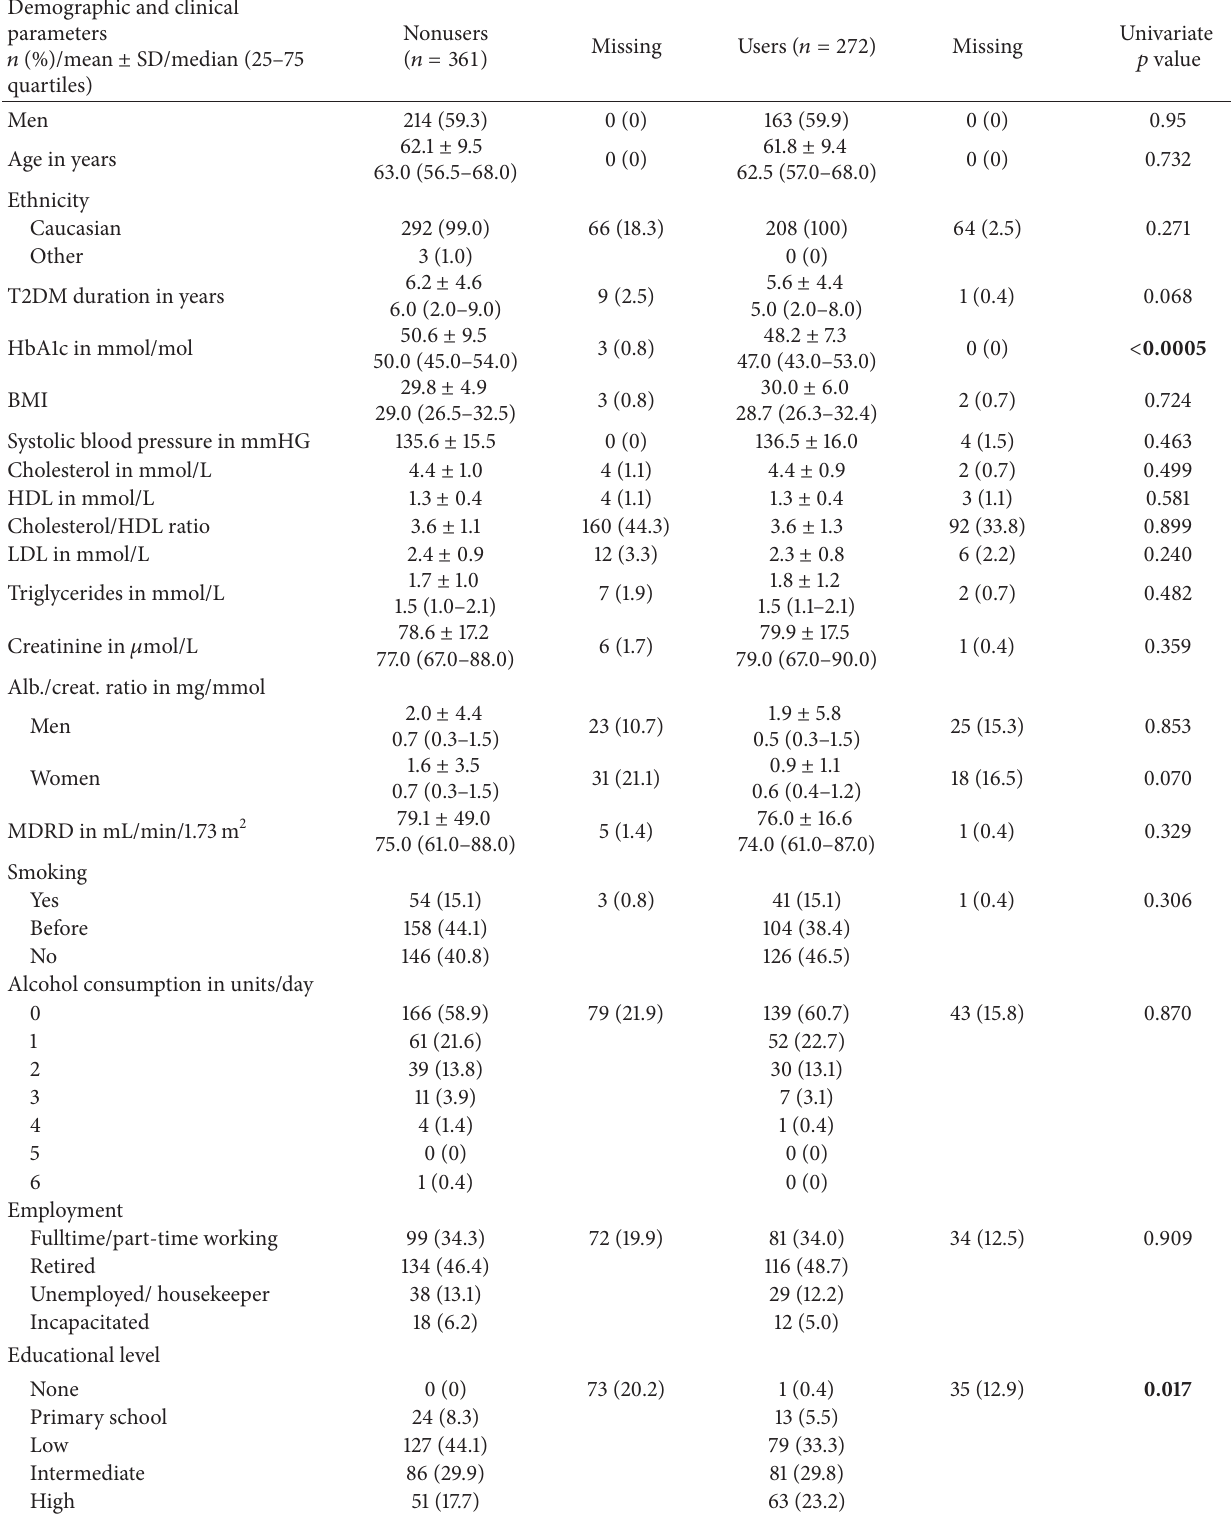
Table 4: Demographic and clinical characteristics of users and